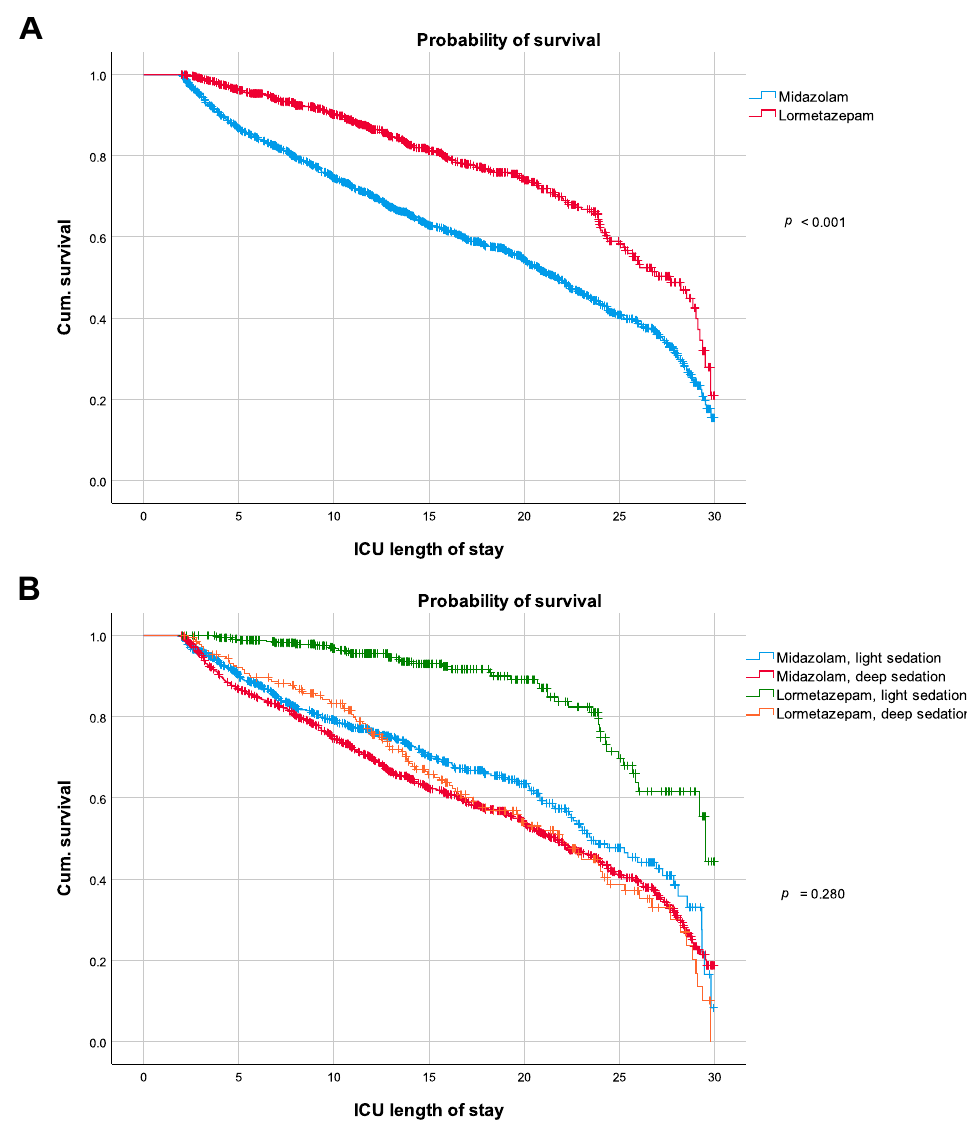
Figure 2. Kaplan–Meier curves of ( A ) the midazolam and lormetazepam groups, and ( B ) the midazolam and lormetazepam groups, stratified by sedation depth. Survival probability between groups was compared using the log-rank test. Cum. survival, cumulative survival; ICU, intensive care unit.